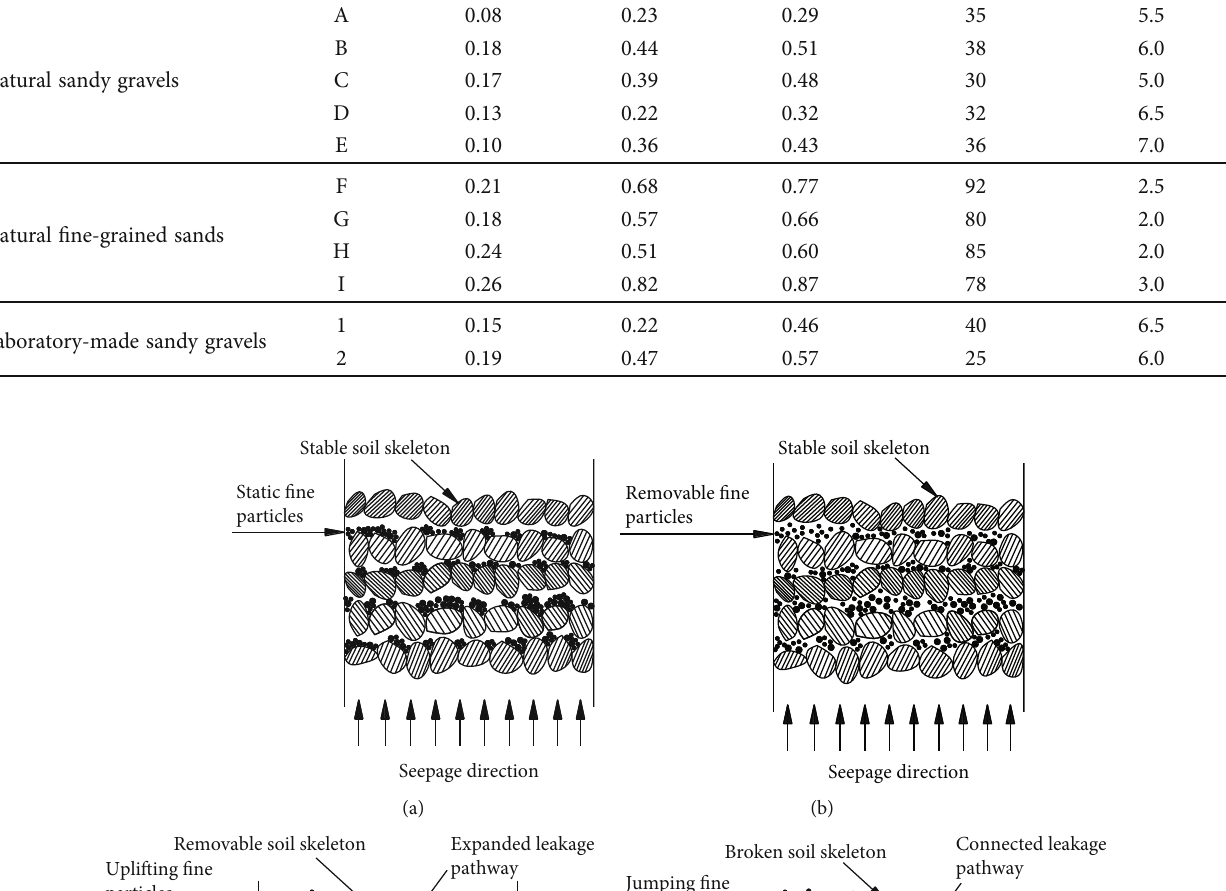
Table 2: Granular soils in the seepage process failure with hydraulic and model-speci fi c parameters. Soil type